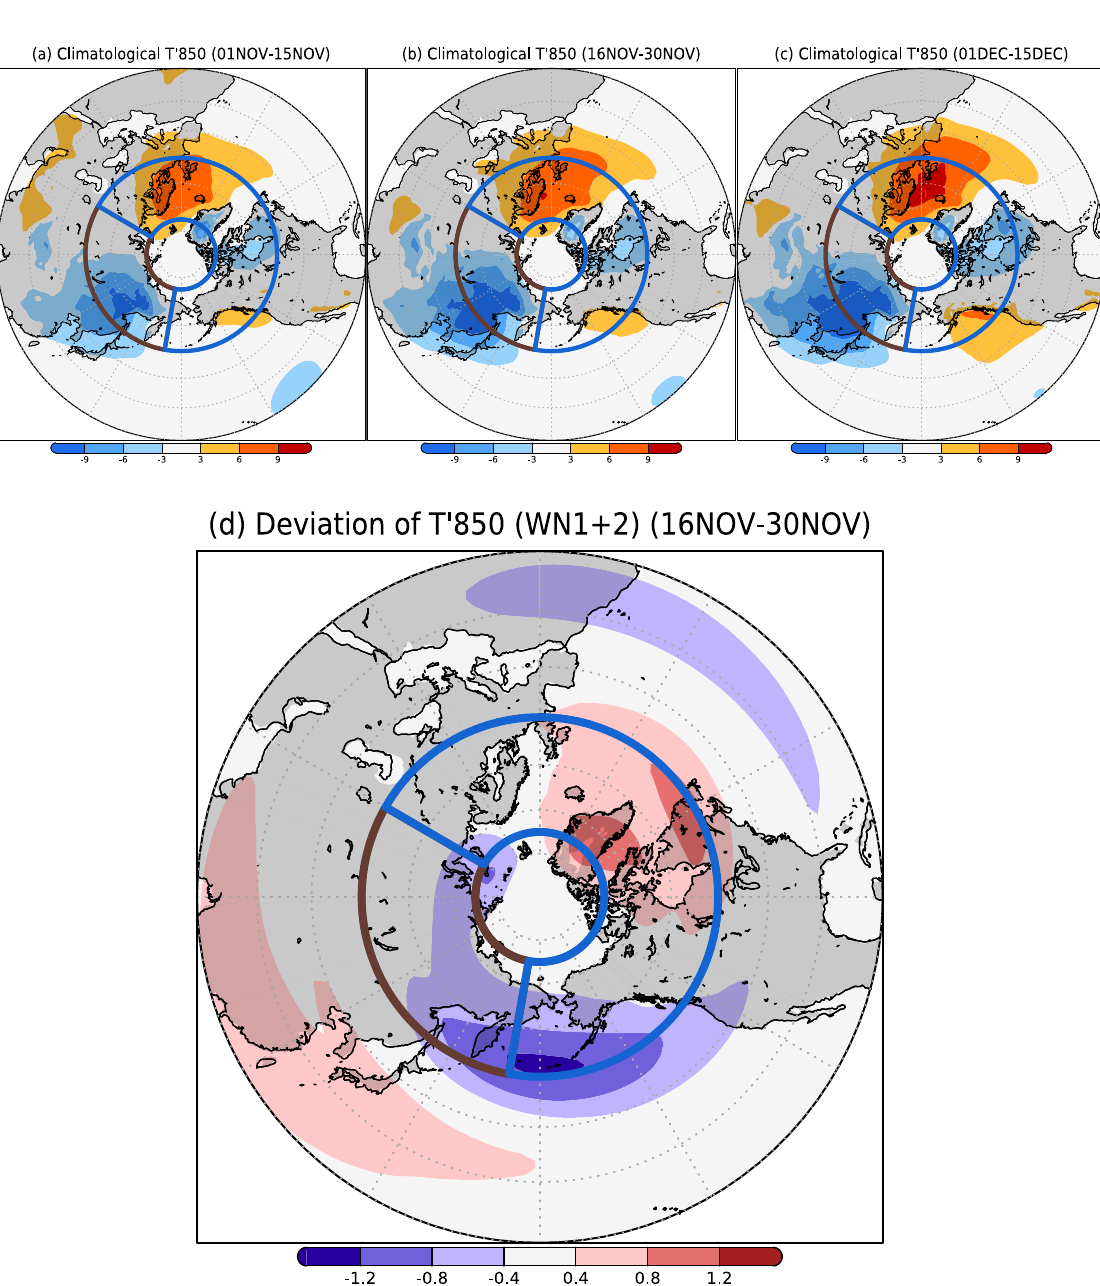
Figure D6. Same as Fig. D5, but for air temperature at 850hPa ( ◦